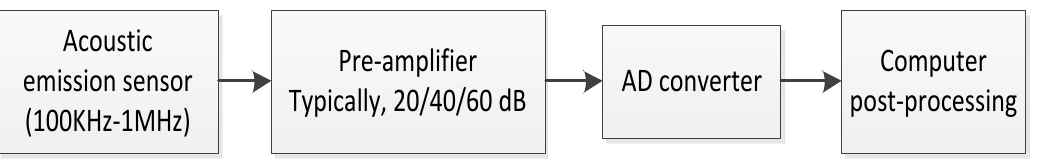
Figure 2. Traditional AE signal acquisition and preprocessing